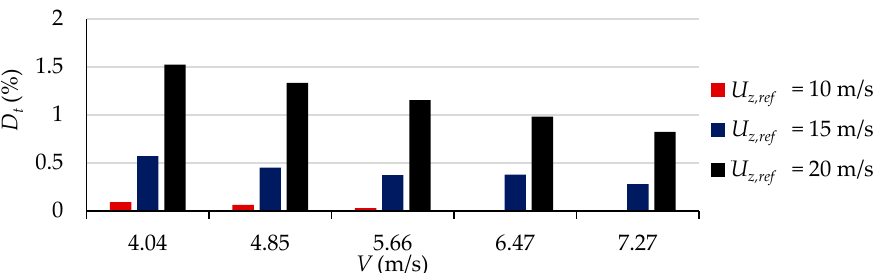
Figure 17. The tether end tensions exhibited with the optimal parameters for different wind and ship speeds and a kite area of 320 m 2 .